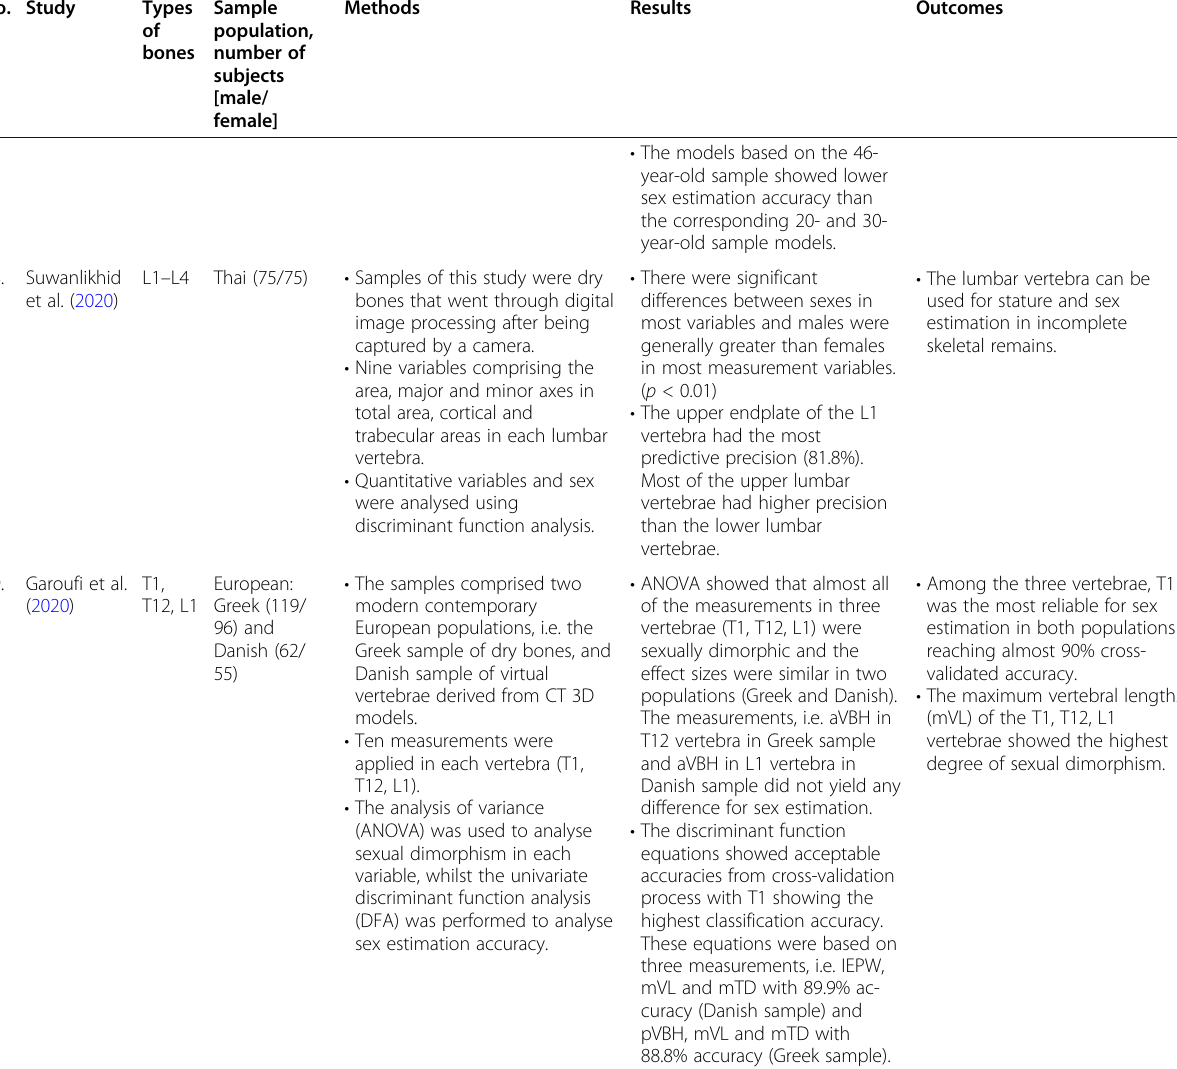
Table 1 The descriptive studies on sexual dimorphism in vertebral bone (Continued) No.